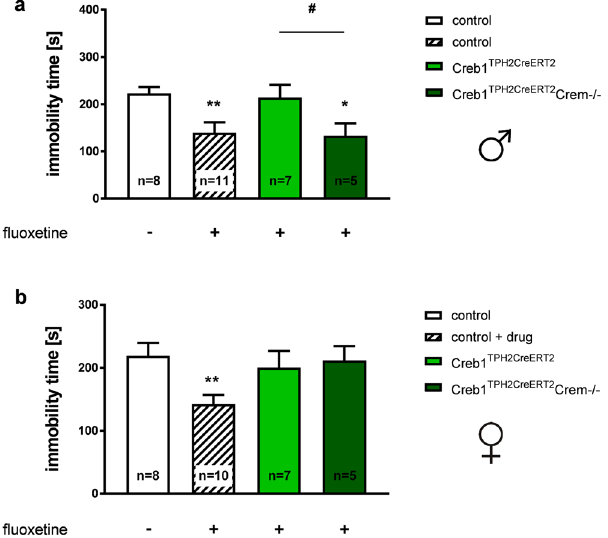
Figure 6. The effect of Creb1 deletion on mouse responsiveness on the TST after fluoxetine. ( a ) Immobility of control, Creb1 TPH2CreERT2 , and Creb1 TPH2CreERT2 /Crem − / − male mice on the TST after fluoxetine treatment (single dose, 10 mg/kg, i.p., 30 min. prior to the test) (ANOVA: F (3,27) = 4.36 p < 0.05; LSD post-hoc test: * p < 0.05, ** p < 0.01 vs control; # p < 0.05 vs Creb1 TPH2CreERT2 ). ( b ) Immobility of control, Creb1 TPH2CreERT2 , and Creb1 TPH2CreERT2 /Crem − / − female mice on the TST after fluoxetine treatment (single dose, 10 mg/kg, i.p., 30 min prior to the test) (ANOVA: F (3,26) = 3.40 p < 0.05; LSD post-hoc test ** p < 0.01 vs control). Data are the mean ± SEM, n =